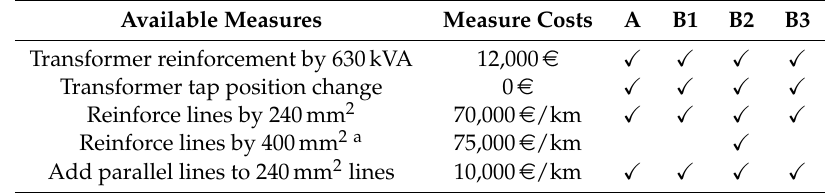
Table 2. Overview of relevant measures and costs of the applied algorithms and variants. Available